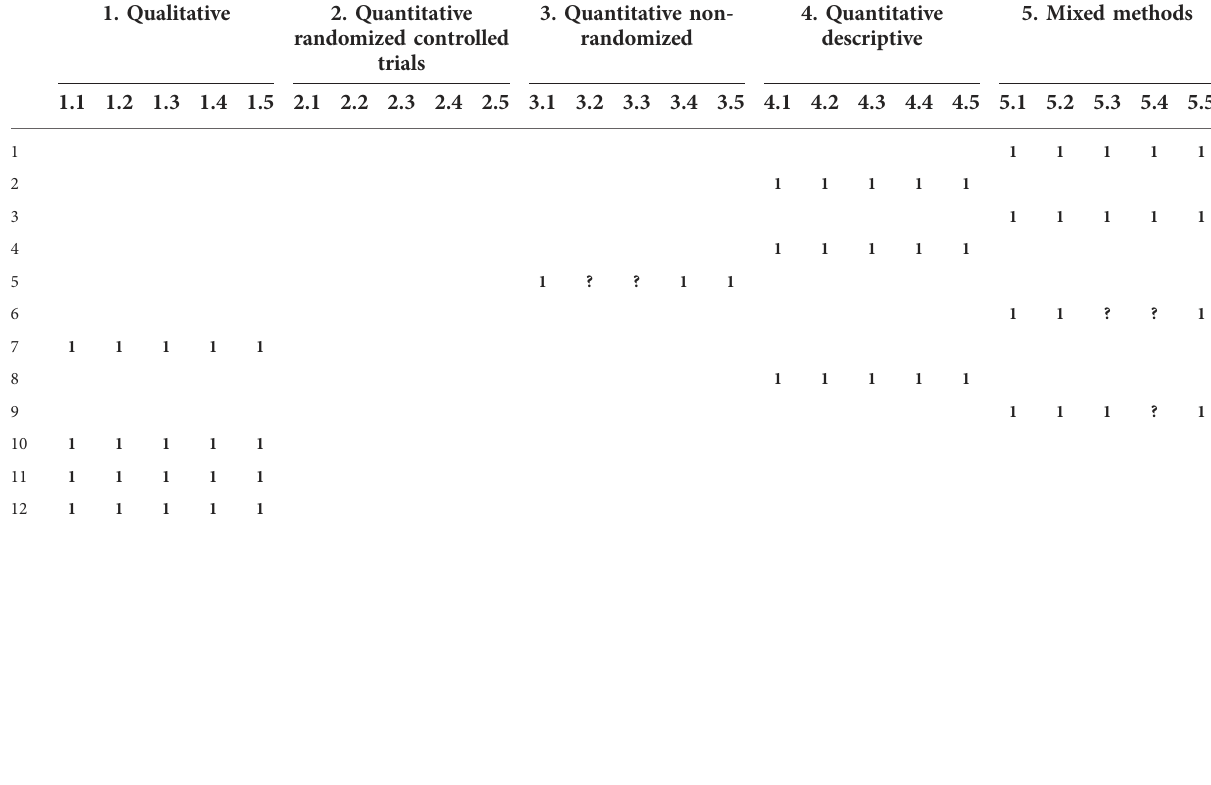
TABLE 2 Reporting the results of the MMAT.